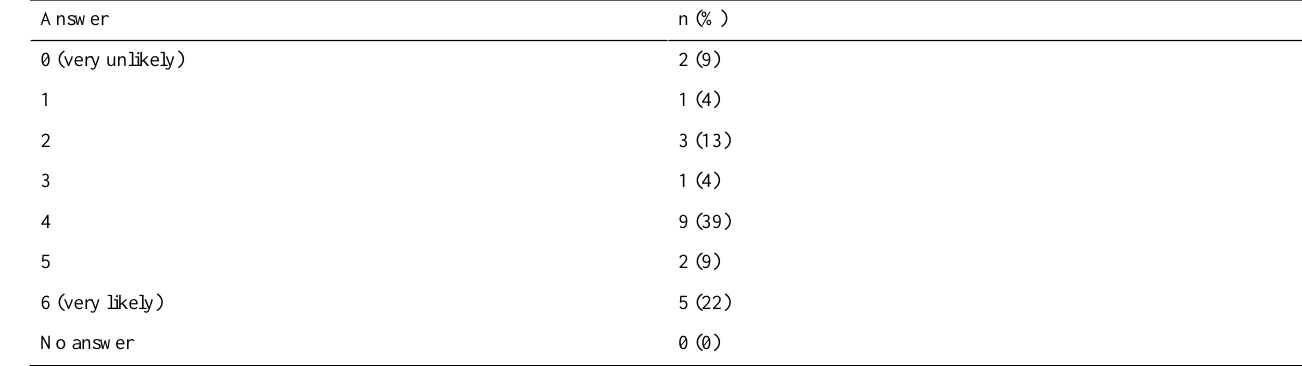
Table 14. Children’s answers about the probability of them joining the community